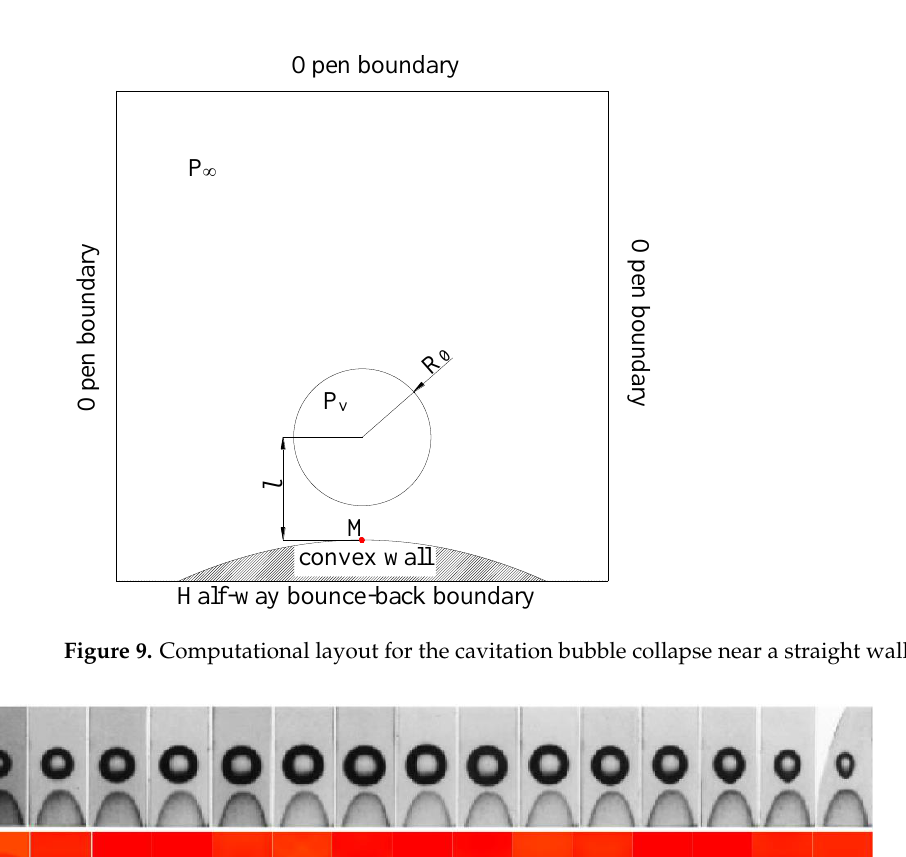
Figure 9. Computational layout for the cavitation bubble collapse near a straight wall.